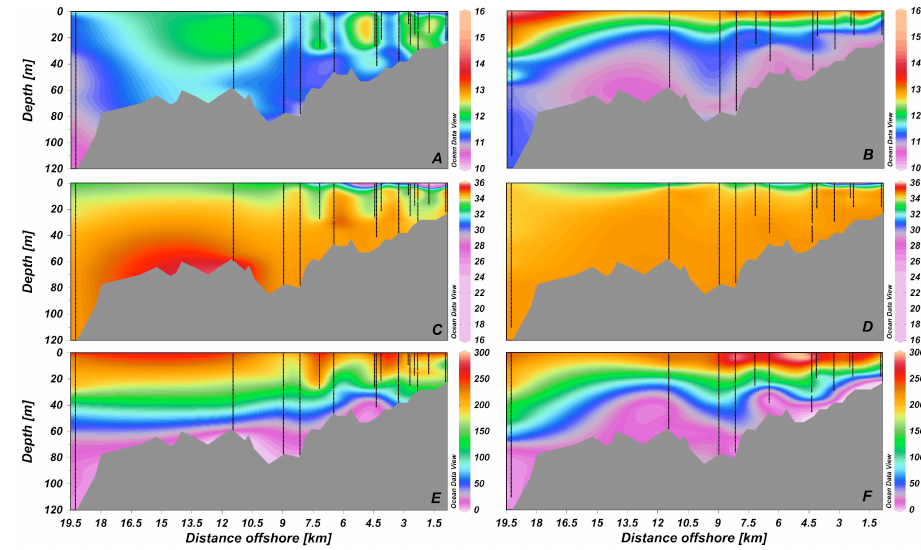
771 ◦ C, panels A, B ), salinity (panels C, D ), oxygen (µM, panels E, F ) during austral winter (left) and 772 Fig. 2. Cross sections of temperature ( spring-summer (right) panels in the Itata river and the adjacent coastal area. X-axis is the distance from the coast. Map generated using the software Ocean Data View (Schlitzer,